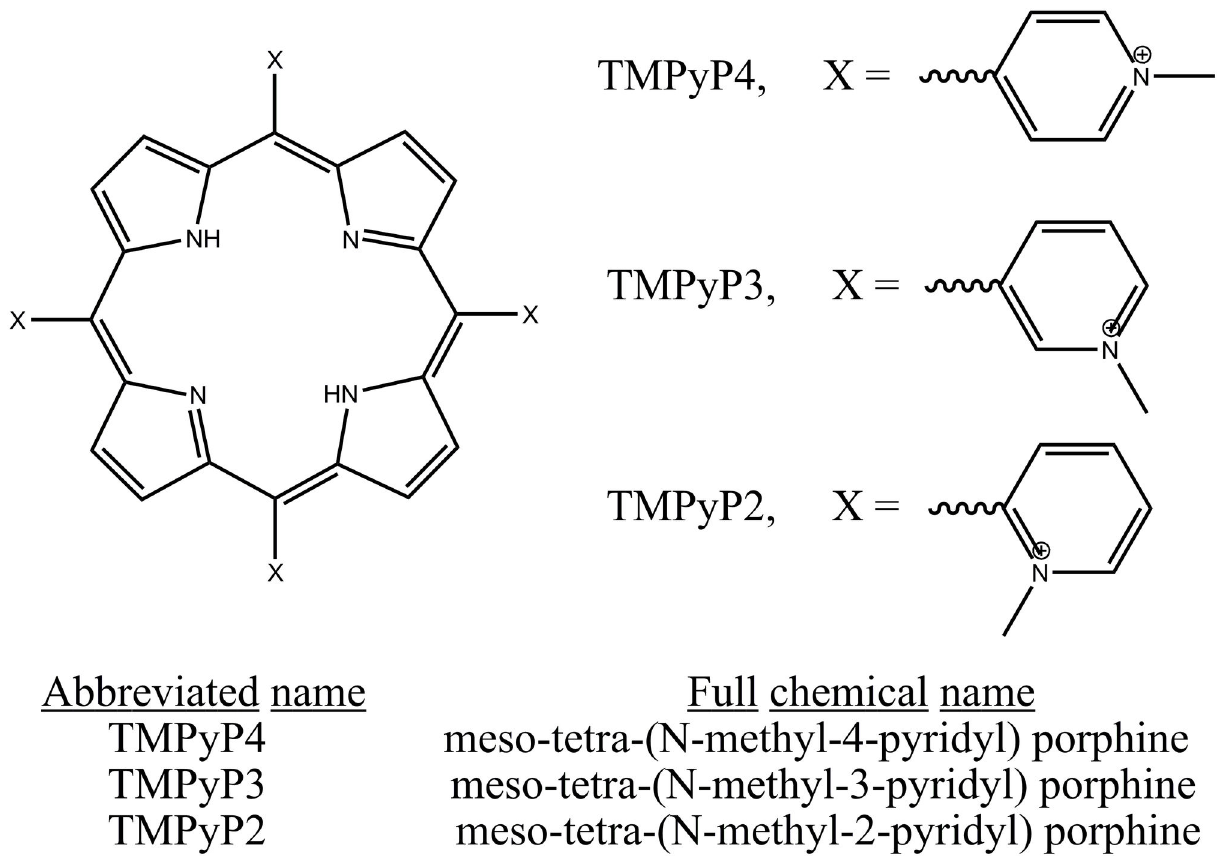
Figure 1. The chemical structures for the planar TMPyP4 and non-planar TMPyP3, and TMPyP2 porphyrin ligands. doi: